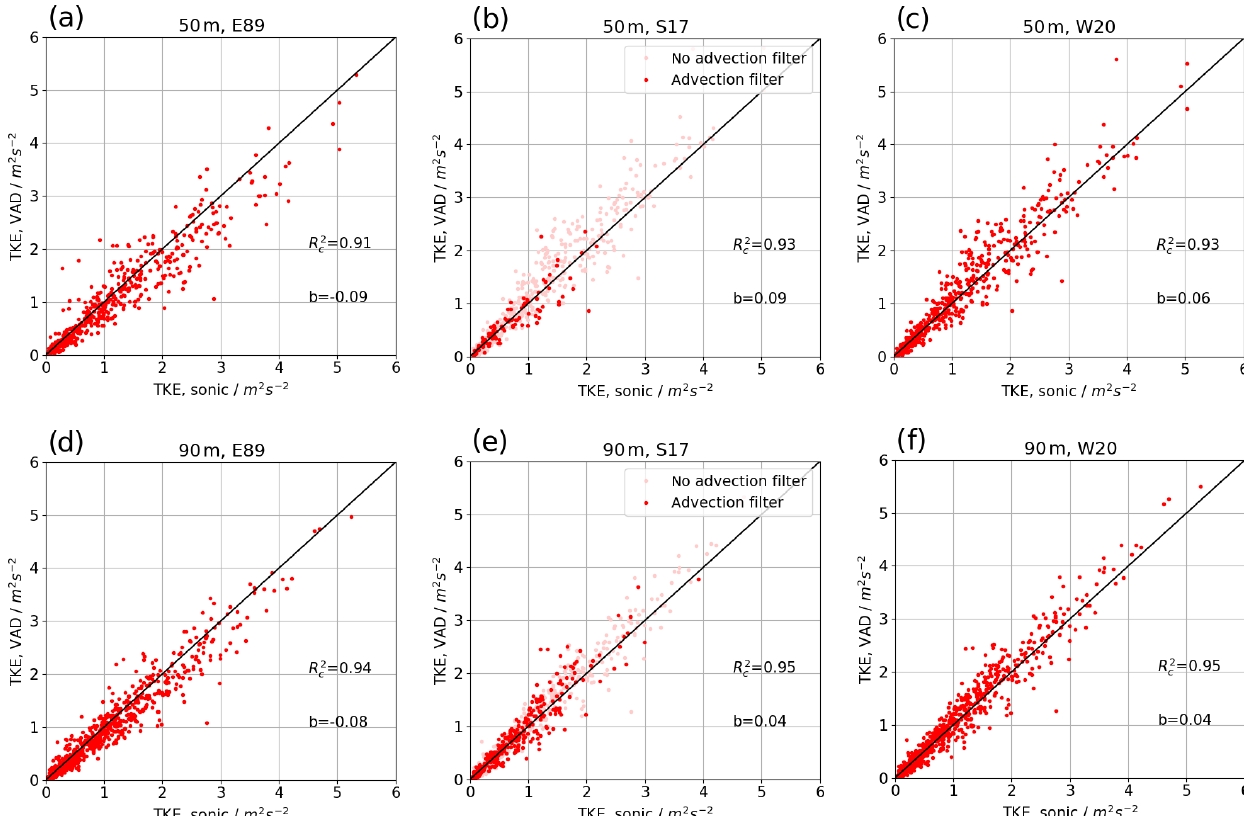
Figure 6. Scatterplot of lidar TKE retrieval against sonic anemometer TKE at the 50m level (a–c) and 90m level (d–f) . E89 retrieval is shown in panels (a) and (d) , S17 retrieval in panels (b) and (e) , and W20 retrieval in panels (c) and (f) . The light red dots in panels (b) and (e) show all TKE estimates with no filter for advection; the dark red dots have the advection filter